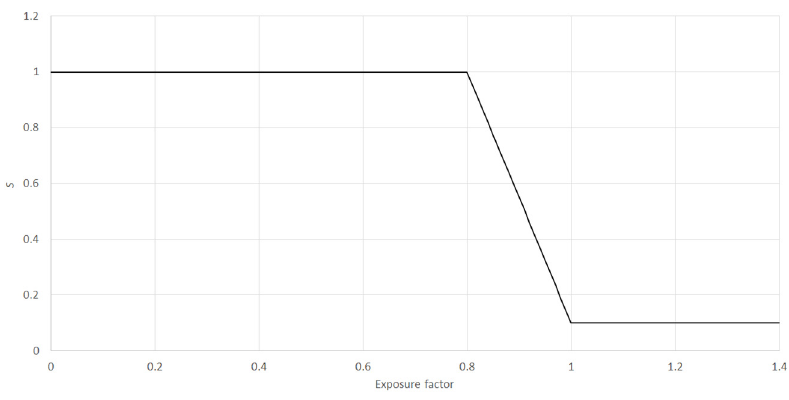
Figure 6. Schematic showing the change of stiffness with exposure factor.